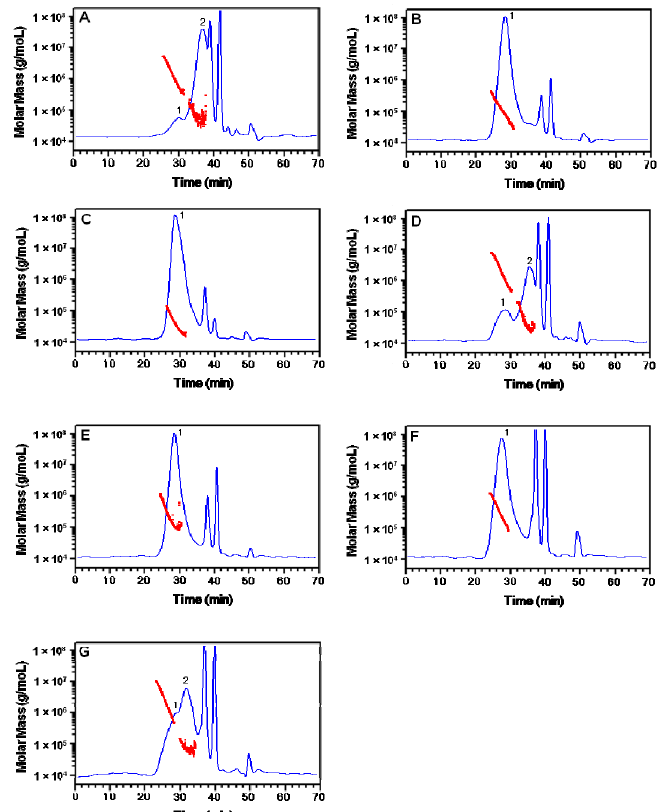
Figure 2. HPSEC-RID profiles with molecular weight distribution of polysaccharides from Dendrobium officinale from ( A ) Yunnan, ( B ) Anhui, ( C ) Zhejiang ( D ) D. fimbriatum from Yunnan, ( E ) D. huoshanense from Anhui, ( F ) D. nobile and ( G ) D. chrysotoxum from